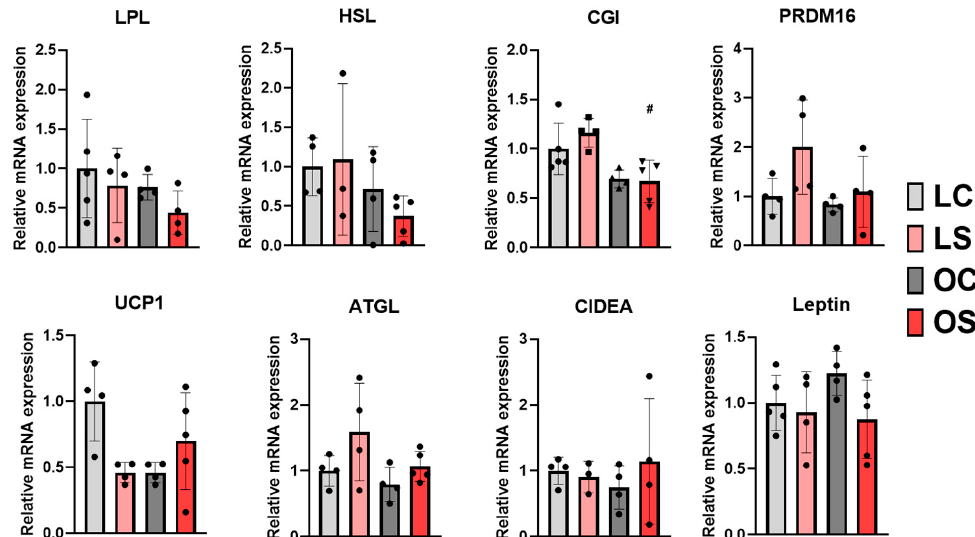
Figure 8. Gene expression lipid metabolism and mitochondrial function in visceral adipose tissue. LC, lean control; LS, lean supplemented with sofrito ; OC, obese control; OS, obese supplemented with sofrito . # p < 0.05 vs. LS. ATGL, adipose triglyceride lipase; CGI, comparative gene identification 58 ( α / β hydrolase); CIDEA, cell death activator; HSL, hormone-sensitive lipase; LPL, lipoprotein lipase; PRDM16, PR domain-containing 16, UCP1, uncoupling protein 1.